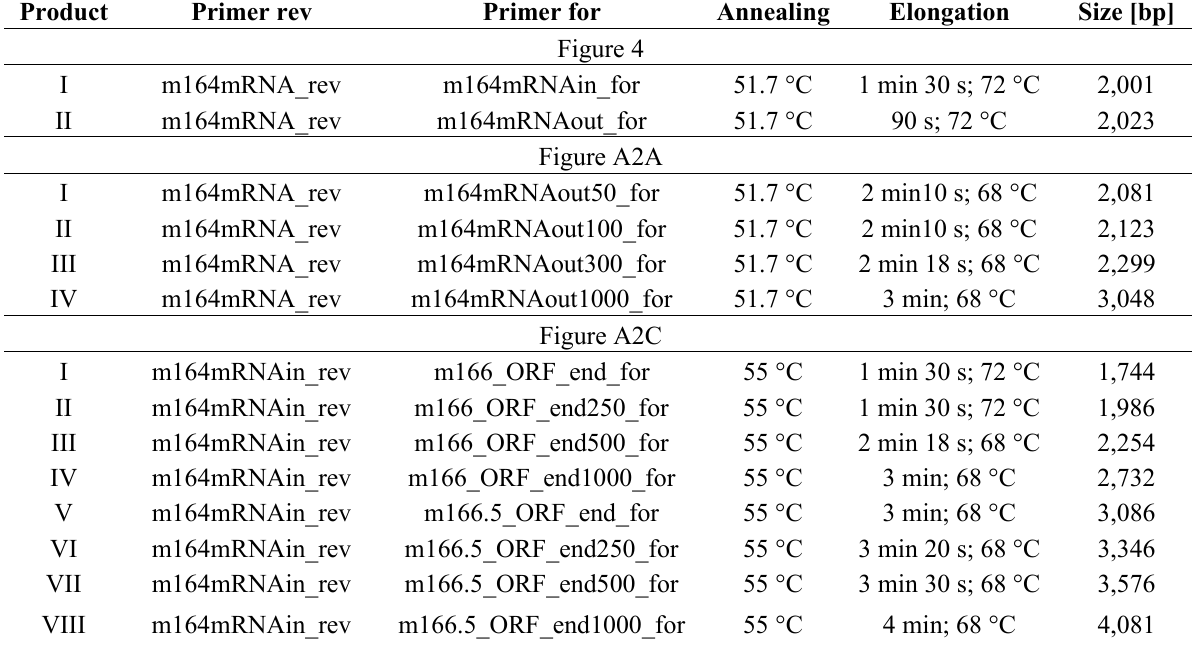
Appendix Table A2. PCR cycling conditions used in this